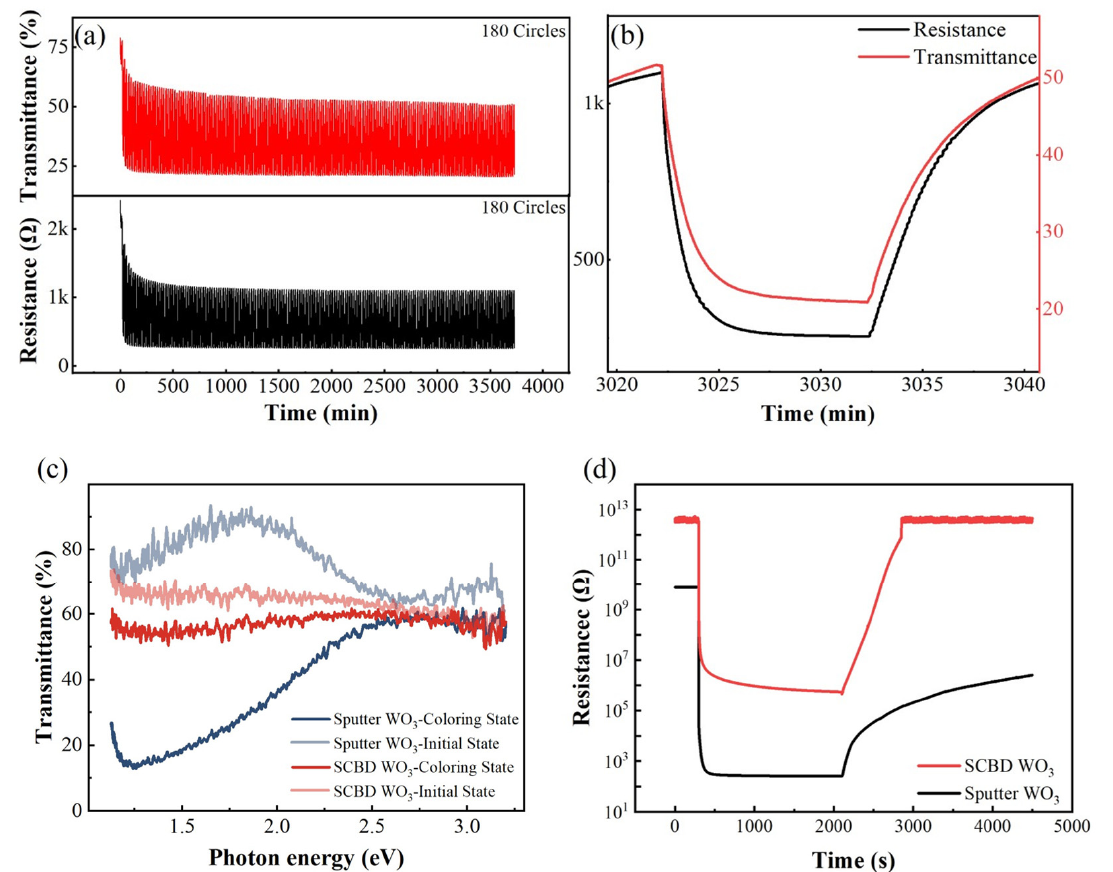
Figure 10. Simultaneous measurement of electrical and optical signals: ( a ) cyclical test for transmit- tance and resistance responses of sputtered WO 3 film to 2% H 2 –air admixture at 80 °C; ( b ) enlarged view of 150th cycle of data shown in ( a ); ( c , d ) spectroscopic and resistive responses of sputtered WO 3 film and SCBD WO 3 film to 2% H 2 in air measured at 80 °C. The applied voltage for electrical signal measurements is 1 V.